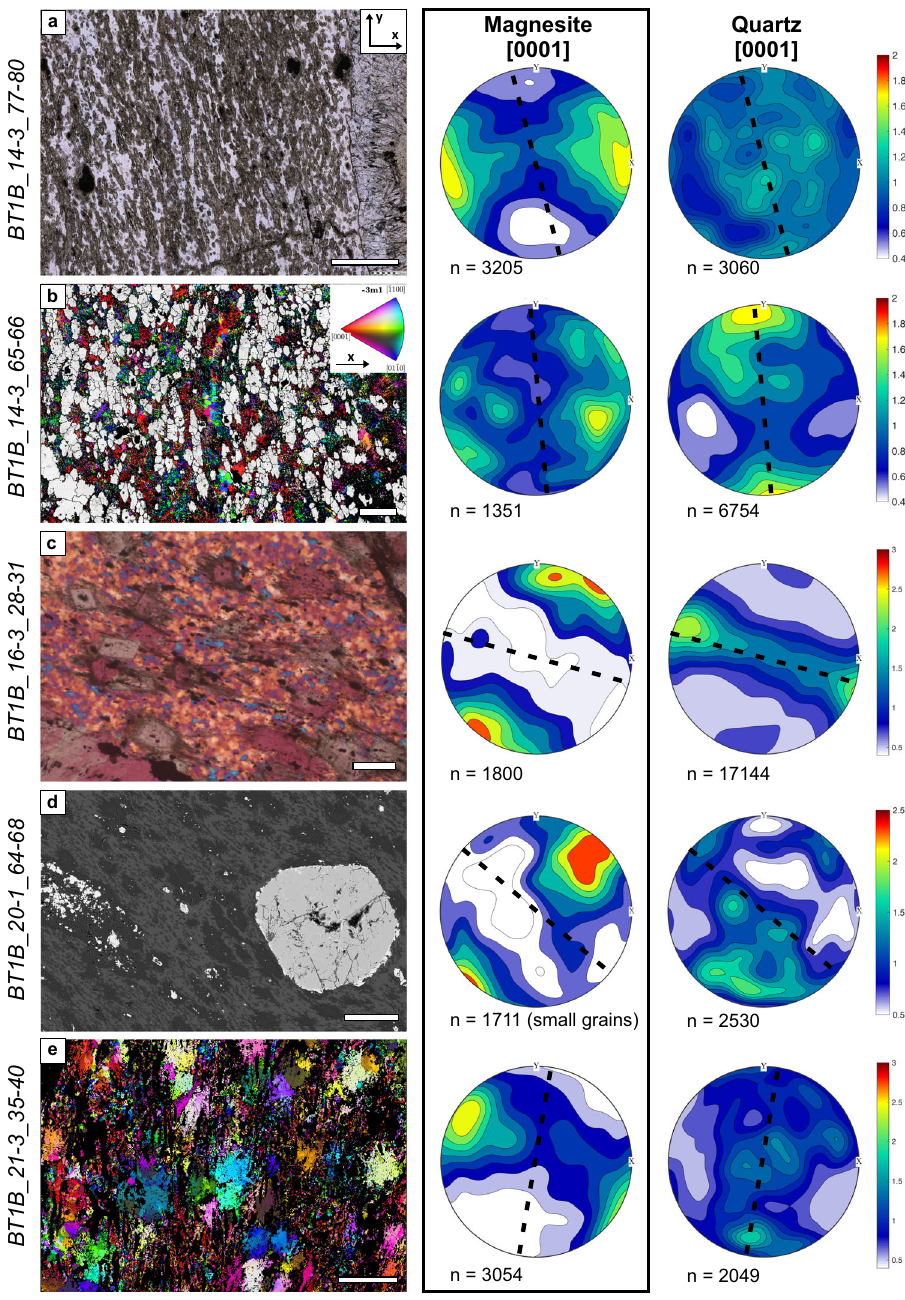
Fig. 4 Microstructures in listvenites with penetrative foliation and corresponding contoured pole fi gures of magnesite and quartz c-axes (1 point per grain; lower hemisphere) in thin section reference (x, y coordinates see inset in a). The black dotted line in pole fi gures shows the orientation of the foliation trace in thin section based on the elongation direction of magnesite grains; contours are multiples of a random distribution. The orientation and strength of crystallographic preferred orientation of [1014] is not shown, it is similar to [0001]. Pole fi gures based on all points (not shown) have similar distributions; full pole fi gures including a- and m- axes see Supplementary fi gs. S8 – S18. a plane polarized light (ppol) image; b quartz orientations (ipf colorscale see inset), and kernel average misorientation of magnesite grains in grey; c crossed polarized light with 1 λ -plate; d back-scattered electron image; e magnesite orientations (colorscale see inset in b ); black = other phases, not indexed. Scale bar in a is 500 µ m, in b – e 100 µ